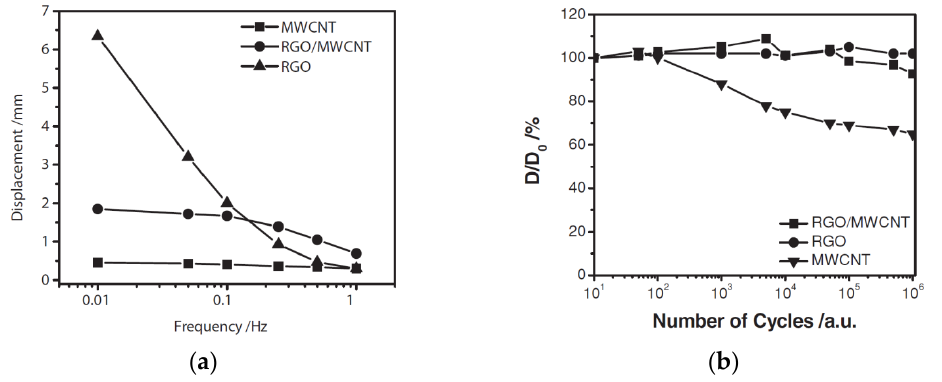
Figure 5. Characteristics of the actuators with electrodes based on MWCNTs, graphene (RGO), and their composite (MWCNT/RGO): ( a ) frequency dependencies of the displacement amplitude; ( b ) operational stability depending on the number of cycles. Reproduced from [30] with permission from John Wiley and Sons. Copyright